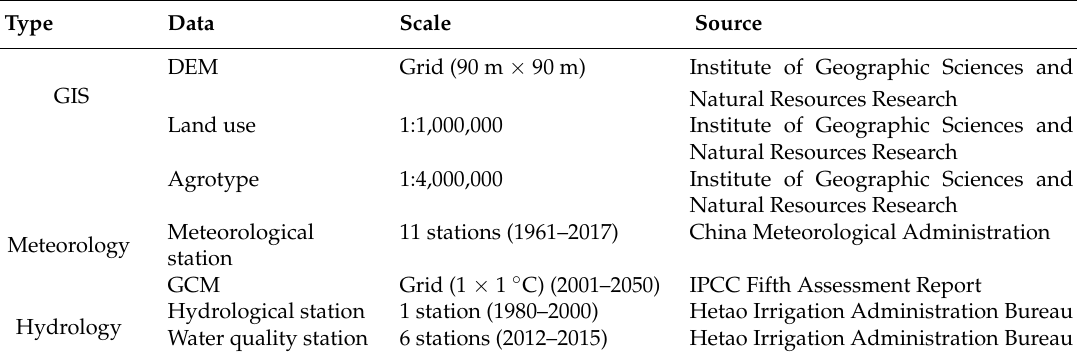
Table 1. The database of the climate change impact assessment in the Hetao area.